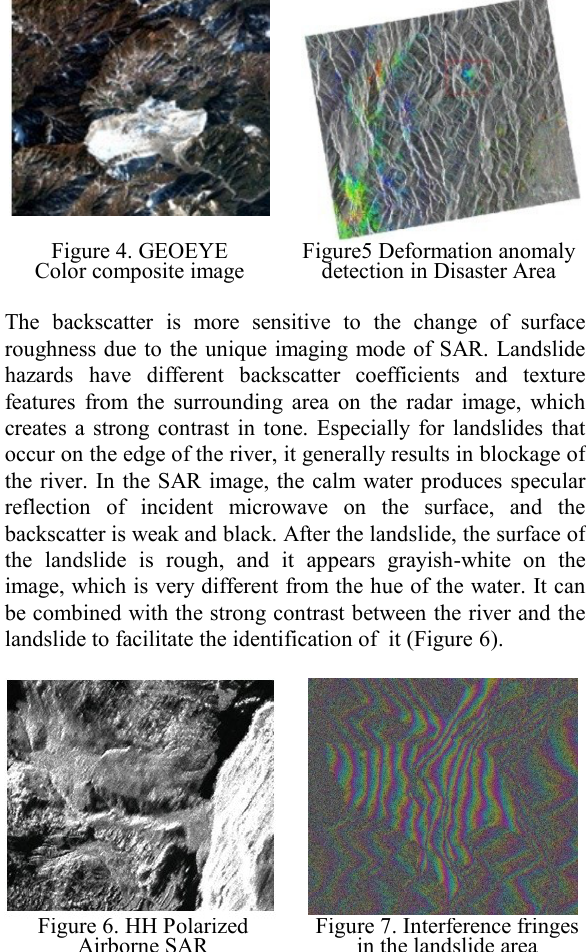
Figure 7. Interference fringes in the landslide